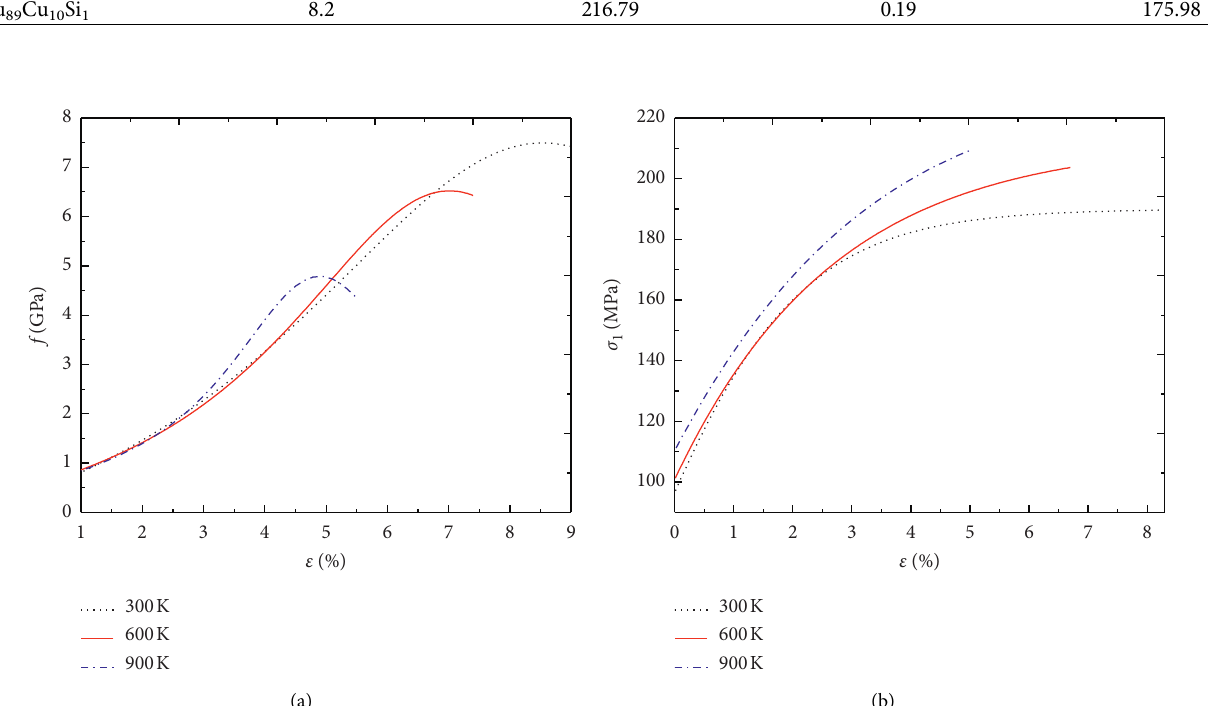
Figure 4: The density of deformation energy f ( ε ) (a) and the real stress σ calculated by the